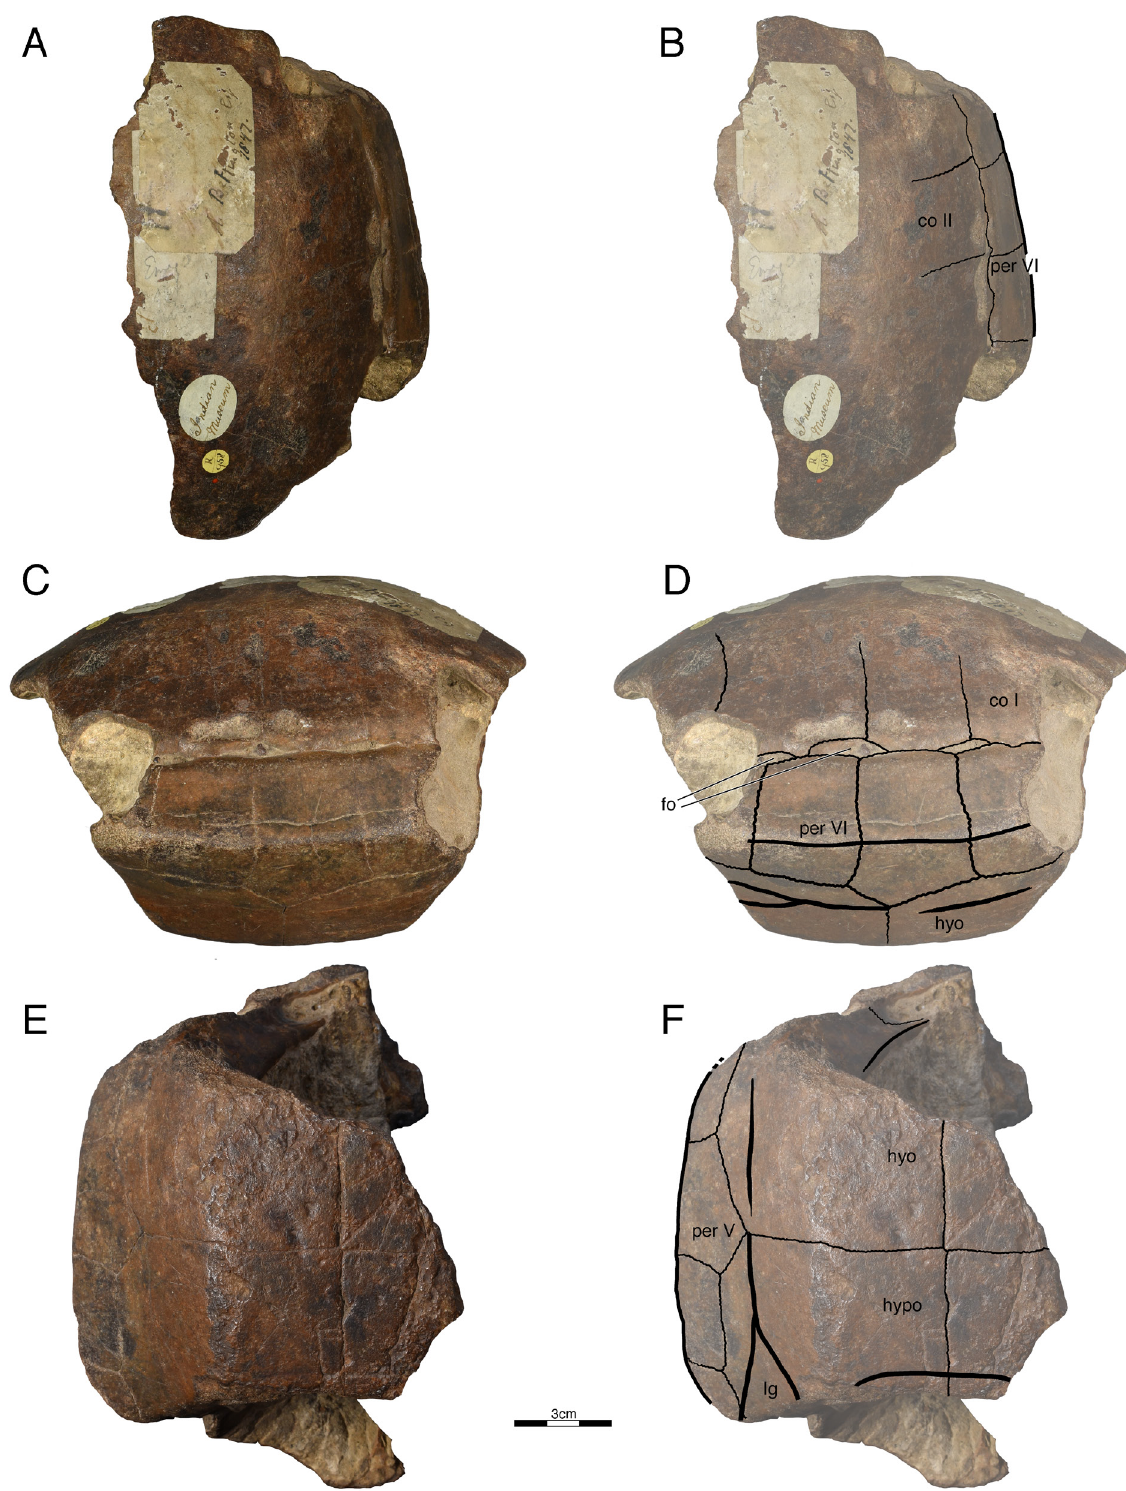
Fig. 6. BMNH R.958, referred to Hardella thurgi (Gray, 1831) by Lydekker (1889b, under the number BMNH R.954), here identified as Palatochelydia indet. A . Photograph of carapace. B . Illustration of carapace. C . Photograph of carapace in lateral view. D . Illustration of carapace in lateral view. E . Photograph of plastron. F . Illustration of plastron. Scale bar: 3